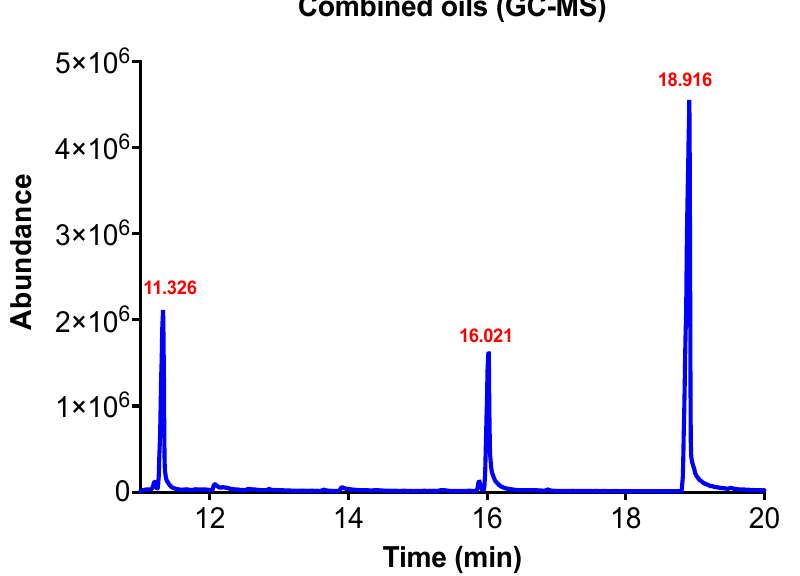
Figure 3. Chromatogram of the combined EO components encapsulated in the prepared particles with retention times 11.326, 16.021, and 18.916 for linalool, geraniol, and eugenol, respectively.